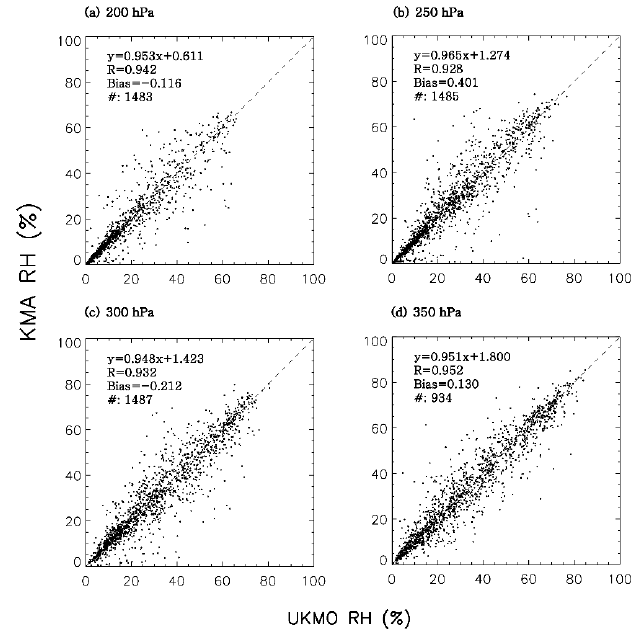
Figure 4. Scatter plots of the relative humidity from the Korea Meteorological Administration model (UM-KMA) versus the United Kingdom Met Office model (UM-UKMO) for ( a ) 200, ( b ) 250, ( c ) 300, and ( d ) 350 hPa in June–December 2012. The dashed lines represent the perfect matches.